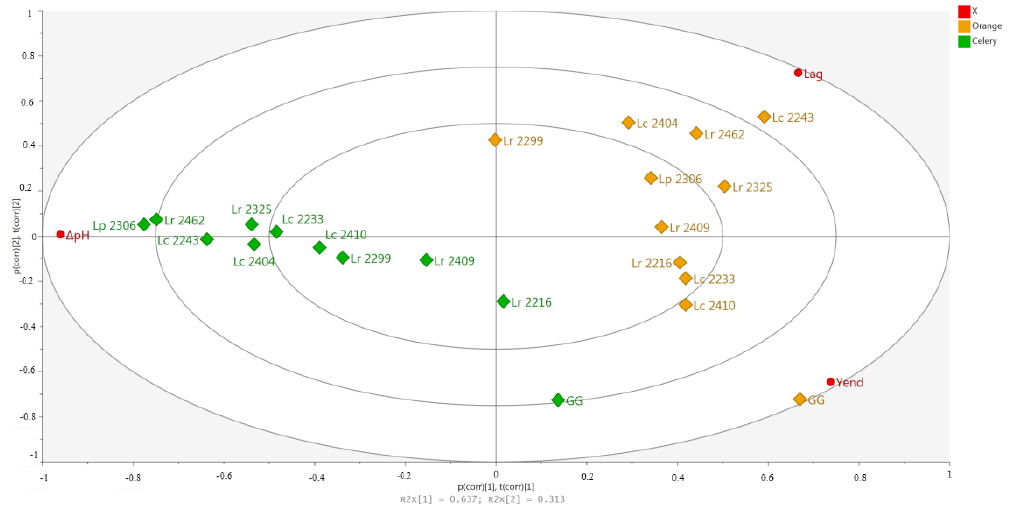
Figure 1. Principal component analysis (PCA) score plot (t1 vs. t2) of the first two PCs of the data set considered against the loading plot (p1 vs. p2). The variables Lag, yEnd and ΔpH are marked (red). The first component explains 64% of the variation and the second component 33%. Observations are colored according to juices.